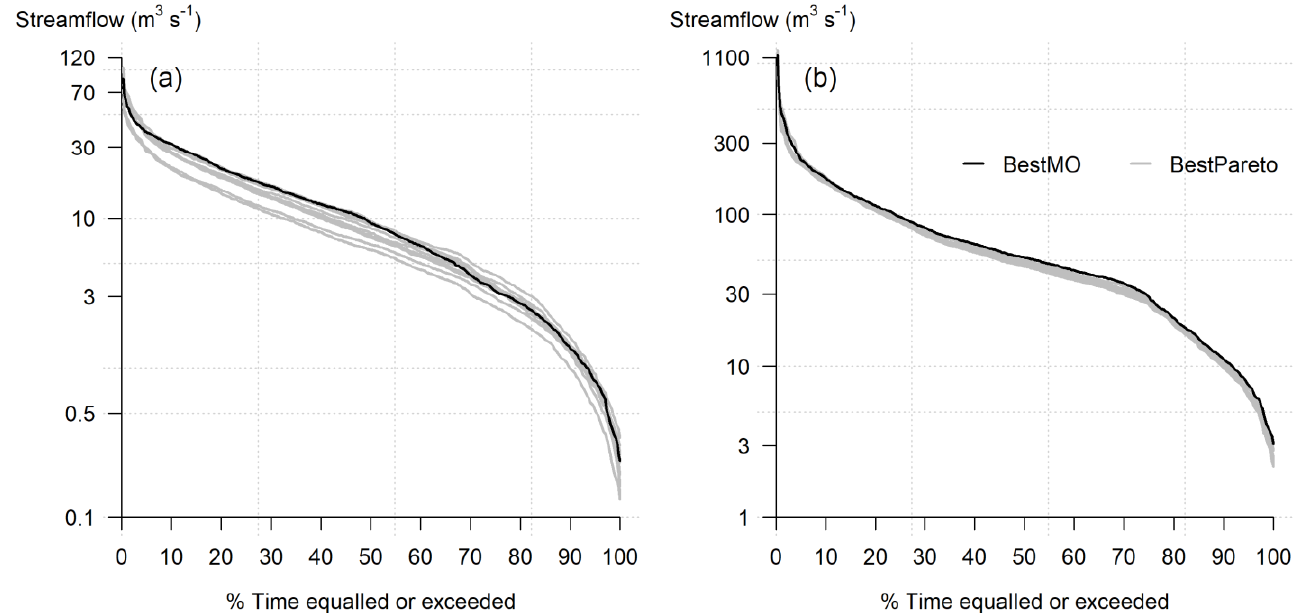
Figure 10. Mean annual FDCs (2002–2007) using the selected Pareto set solutions for the Nyangores River at Bomet ( a ) and the Mara River at Mines ( b ).